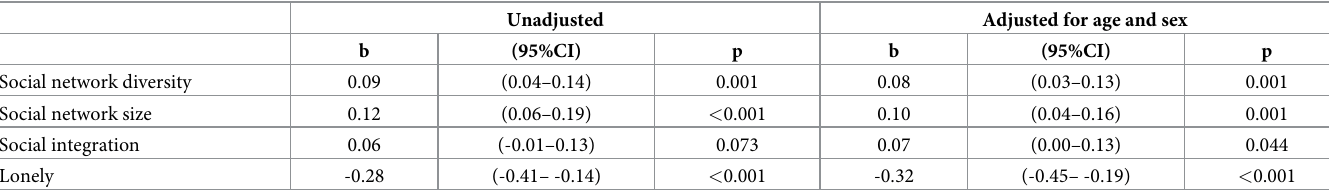
Table 3. Coefficients regressing self-rated health on social relationship